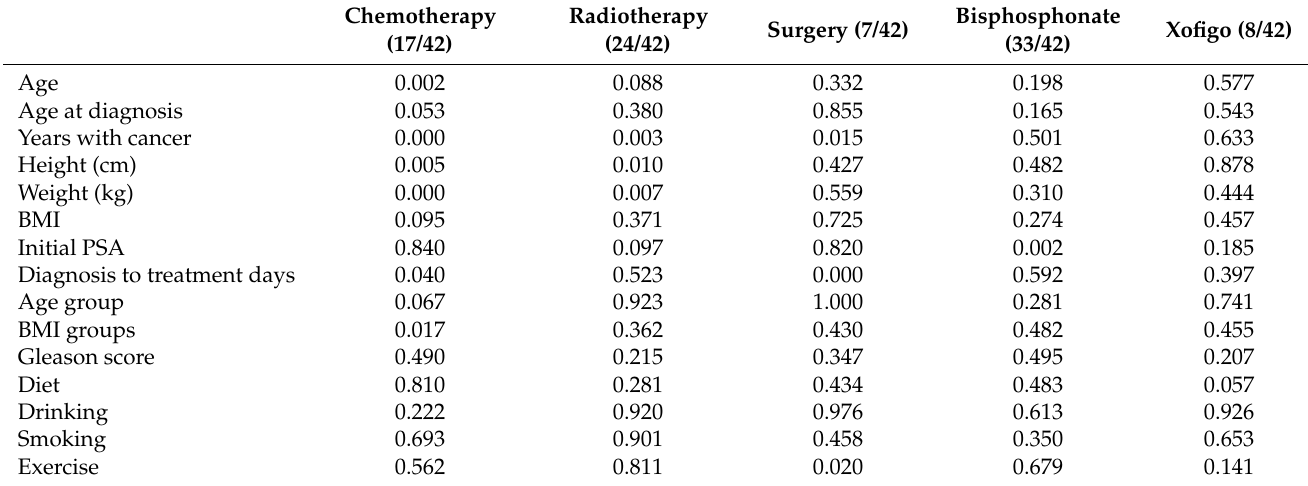
Table 3. Variables used in the analysis for different treatment lines for prostate